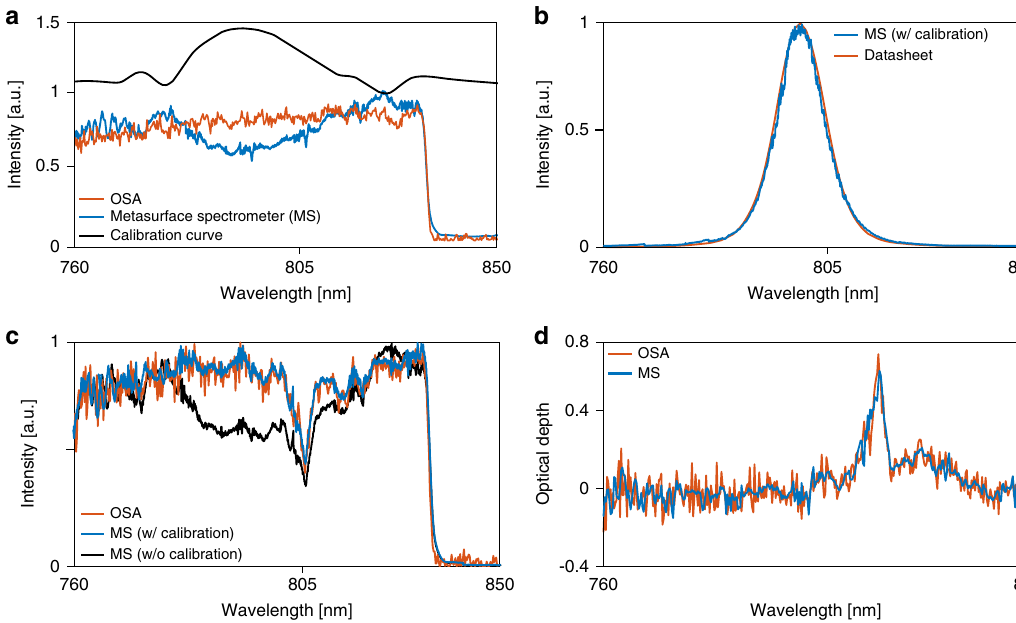
Fig. 5 Sample spectrum measurement results. a Spectrum of a wideband source (a super-continuum laser with an 840-nm short-pass fi lter) measured by a commercial OSA and the metasurface spectrometer (MS). This measurement was used to extract the calibration curve. b Spectrum of a 10-nm band-pass fi lter centered at 800 nm measured by the MS, compared to the spectrum acquired from the fi lter datasheet. c Transmission spectrum of a Nd:YVO crystal sample measured both with a commercial OSA and the MS. d The optical depth of the sample extracted from the spectrum measurements both with the OSA and the